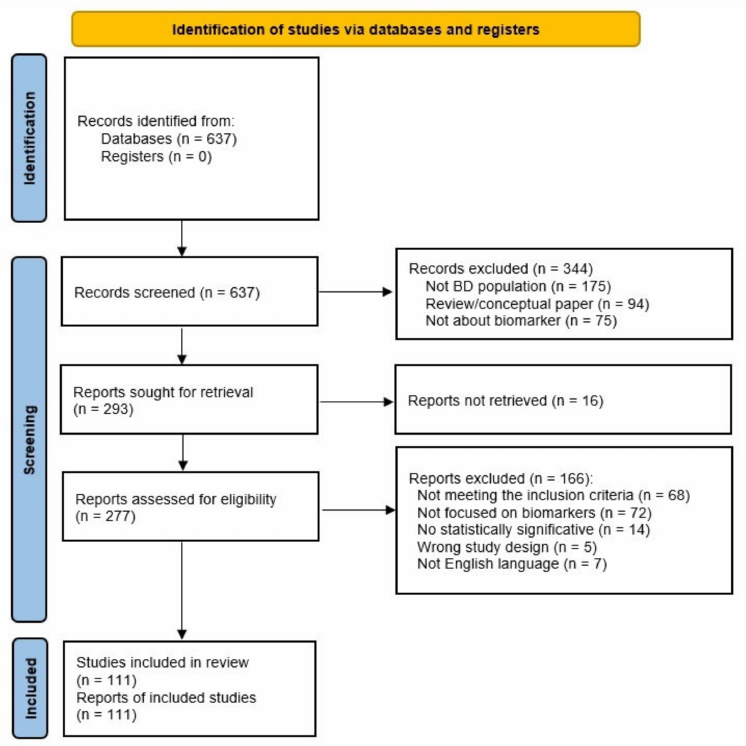
Figure 1. Flowchart of the literature search